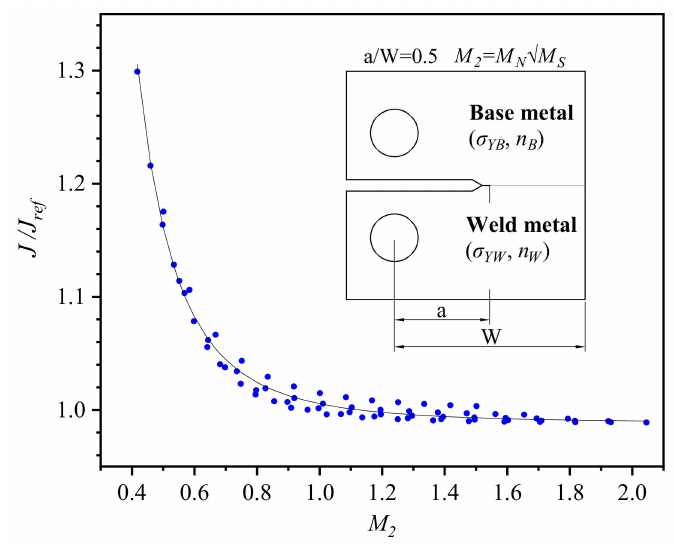
Figure 9. Fitting function of J -integral with different mismatch factors.